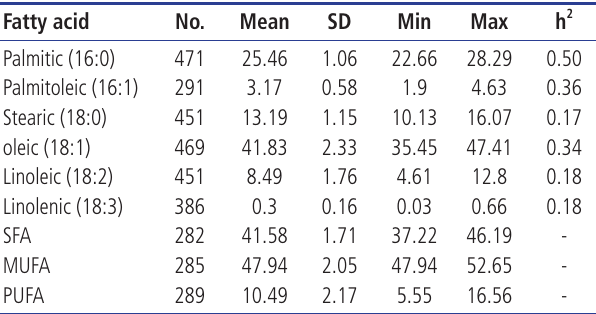
Table 1. Summary statistics for fatty acid composition in Duroc Fatty acid